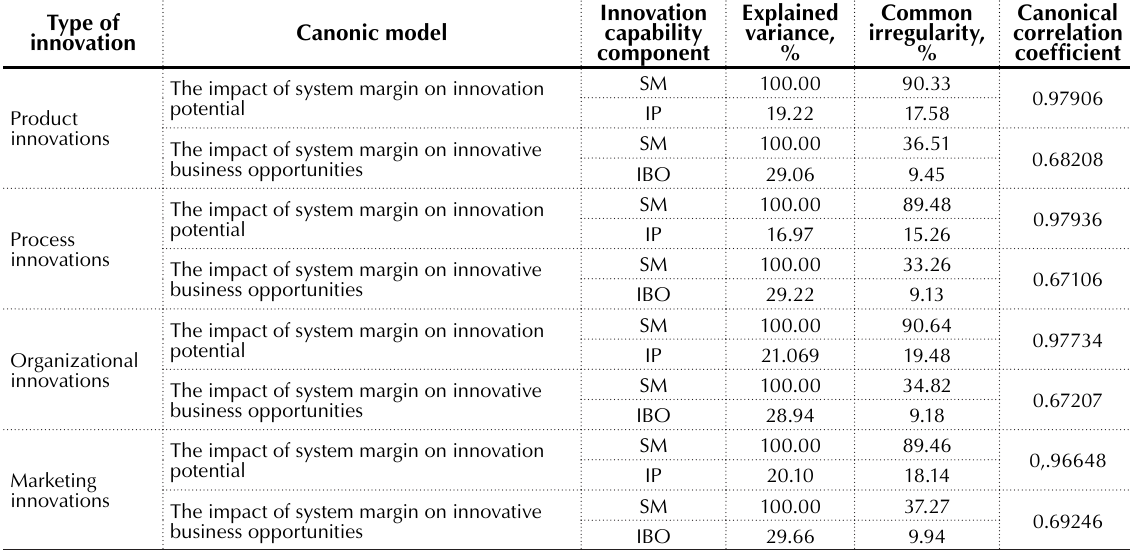
Table 1. Statistical characteristics of the interconnection of innovation capability components by types of